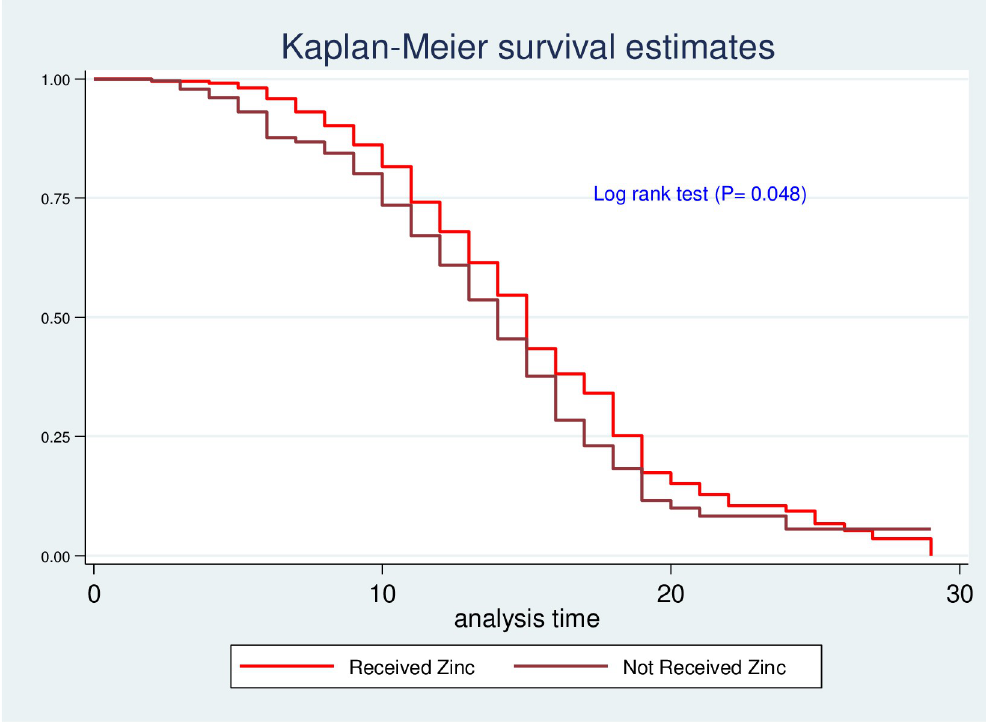
Fig 5. Log-rank survival estimate for time to recovery of SAM children by zinc supplementation.